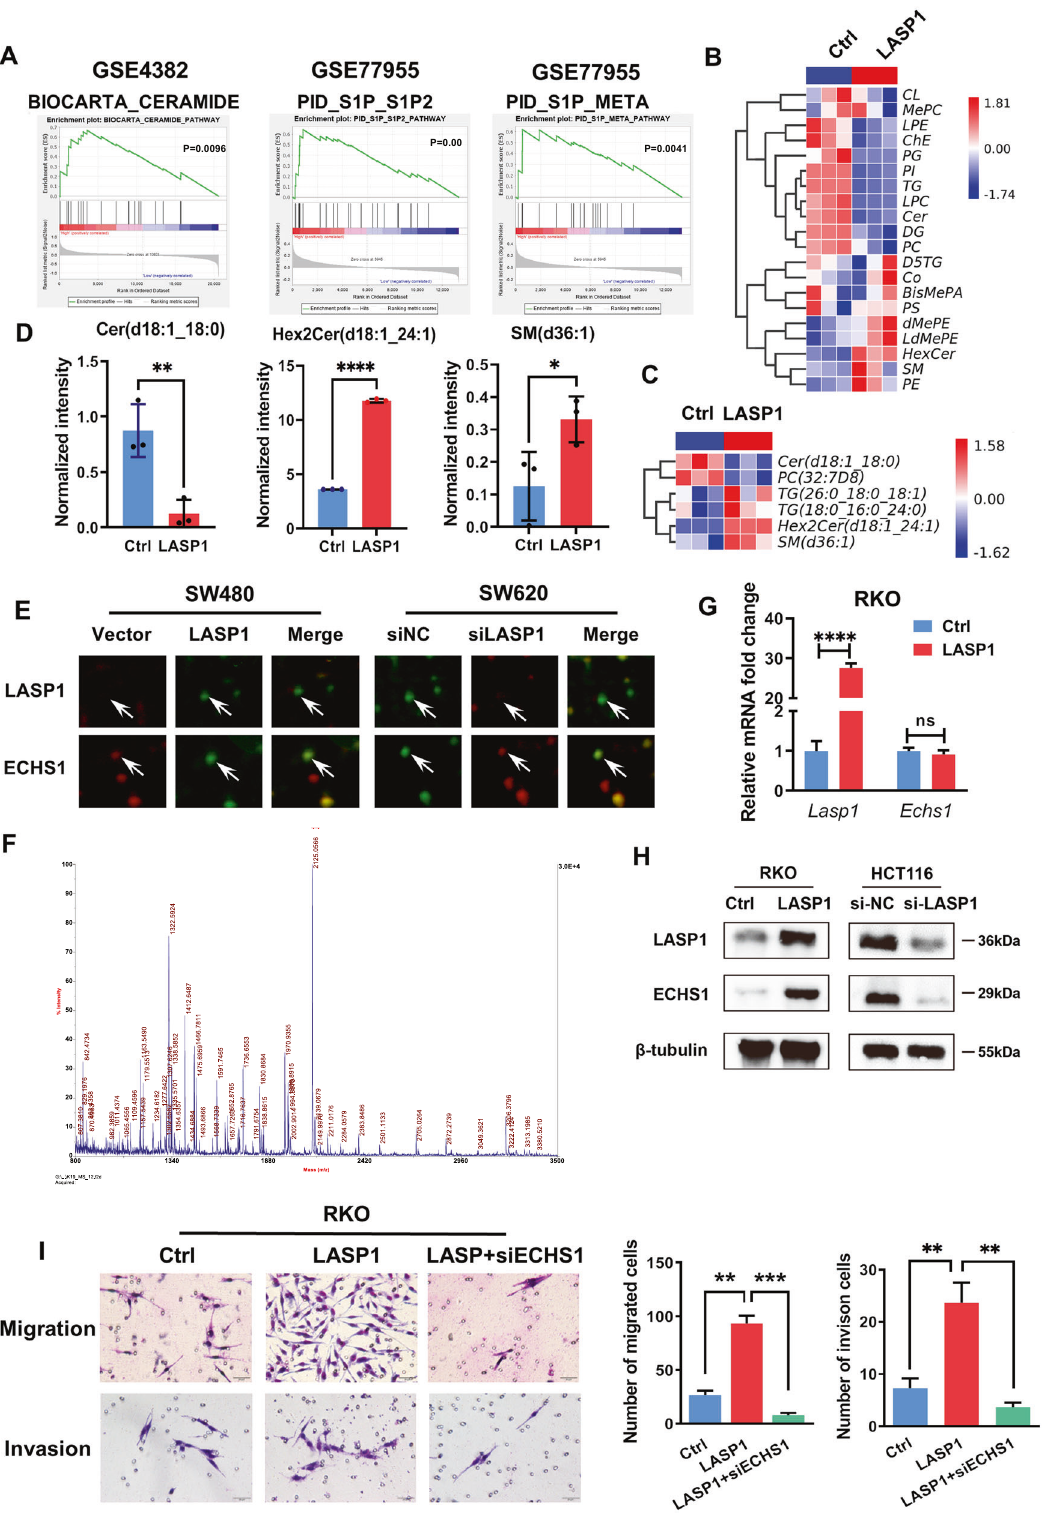
extraction of SW480 cells. As shown in Fig. 2B, when protein synthesis is blocked by CHX, ECHS1 gradually degrades with time. CRC cells were transfected with plasmid-encoding LASP1 or control plasmid, and the degradation of ECHS1 protein was monitored after CHX treatment. Compared with the control